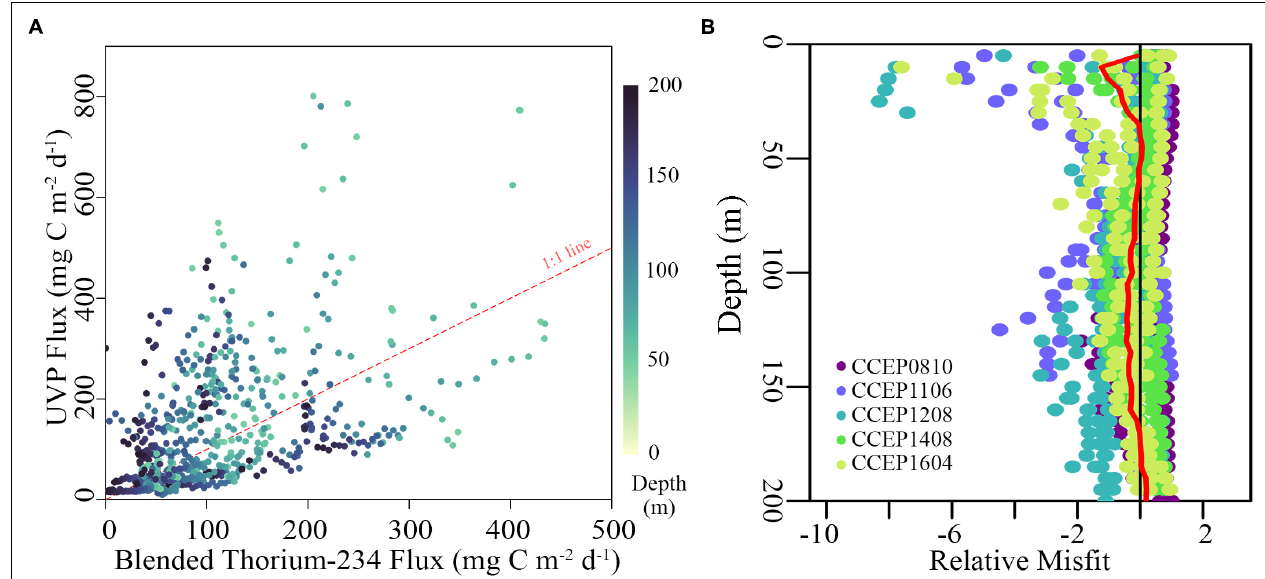
FIGURE 9 | (A) Blended 234 Th-sediment trap flux estimates from 50 to 200 m compared to estimates predicted by the UVP algorithm using the optimized A and B values of 15.4 and 1.05 respectively. Points are colored by depth and the red dashed line is 1:1. (B) Misfit between the UVP flux estimate and the blended 234 Th-method [i.e., (F UVP – F Th )] plotted against depth, with a red line denoting the mean relative misfit (equivalent to AE) across all